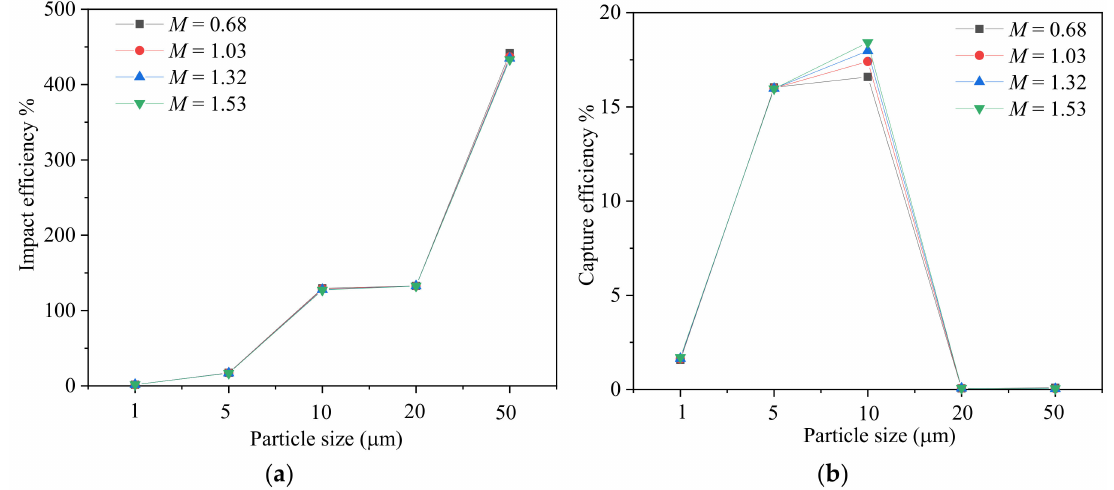
Figure 9. Variation of impact efficiency and capture efficiency with different particle sizes at four blowing ratios. ( a ) Impact efficiency, ( b ) capture